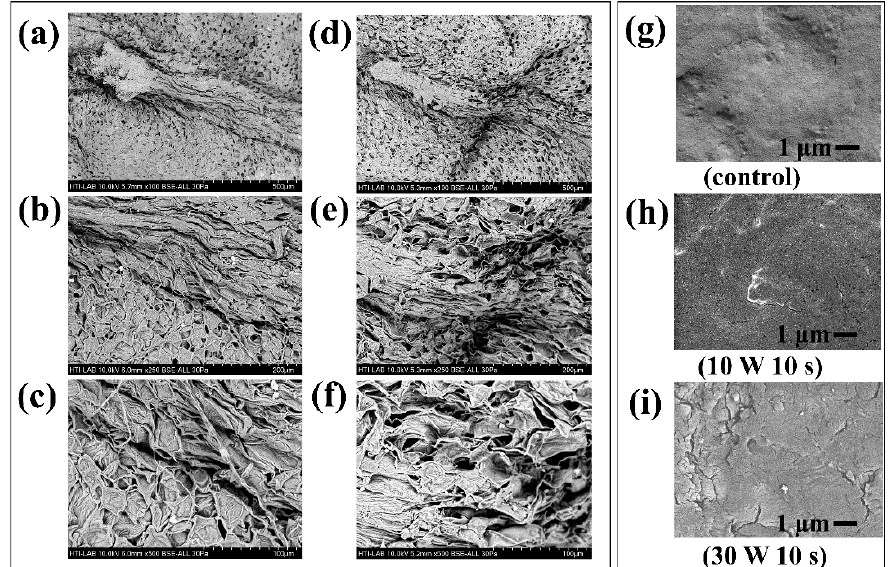
Figure 7. Scanning electron micrographs of ( a – c ) untreated and ( d – f ) H 2 O-plasma-treated Bam- bara hilum (10 W, 10 s). ( g – i ) compares the ( g ) untreated, ( h ) optimized (10 W 10 s), and ( i ) aggres- sive (30 W 10 s) treatment parameters (scale bars for ( a – f ) are 500, 200, and 100 μ m respectively. ( g – i ) have scale bars of 1 μ m.)